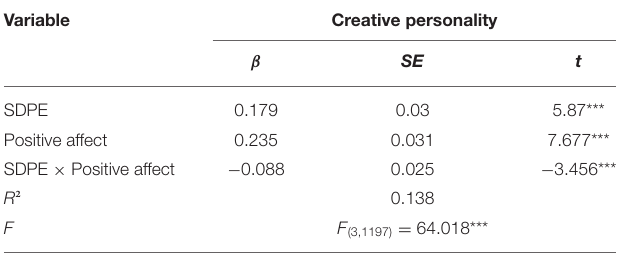
TABLE 3 | Regression analysis results of the moderating effect of positive